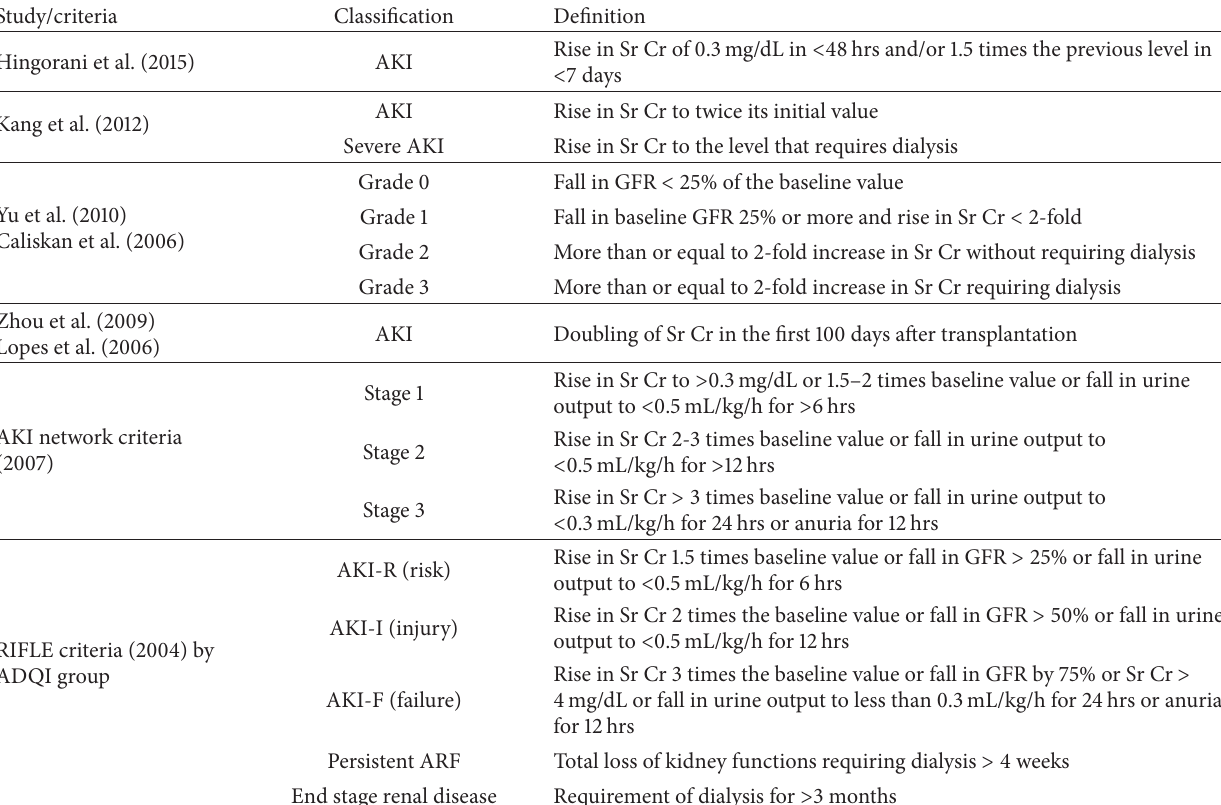
Table 1: Definitions and classification systems used for acute kidney injury.